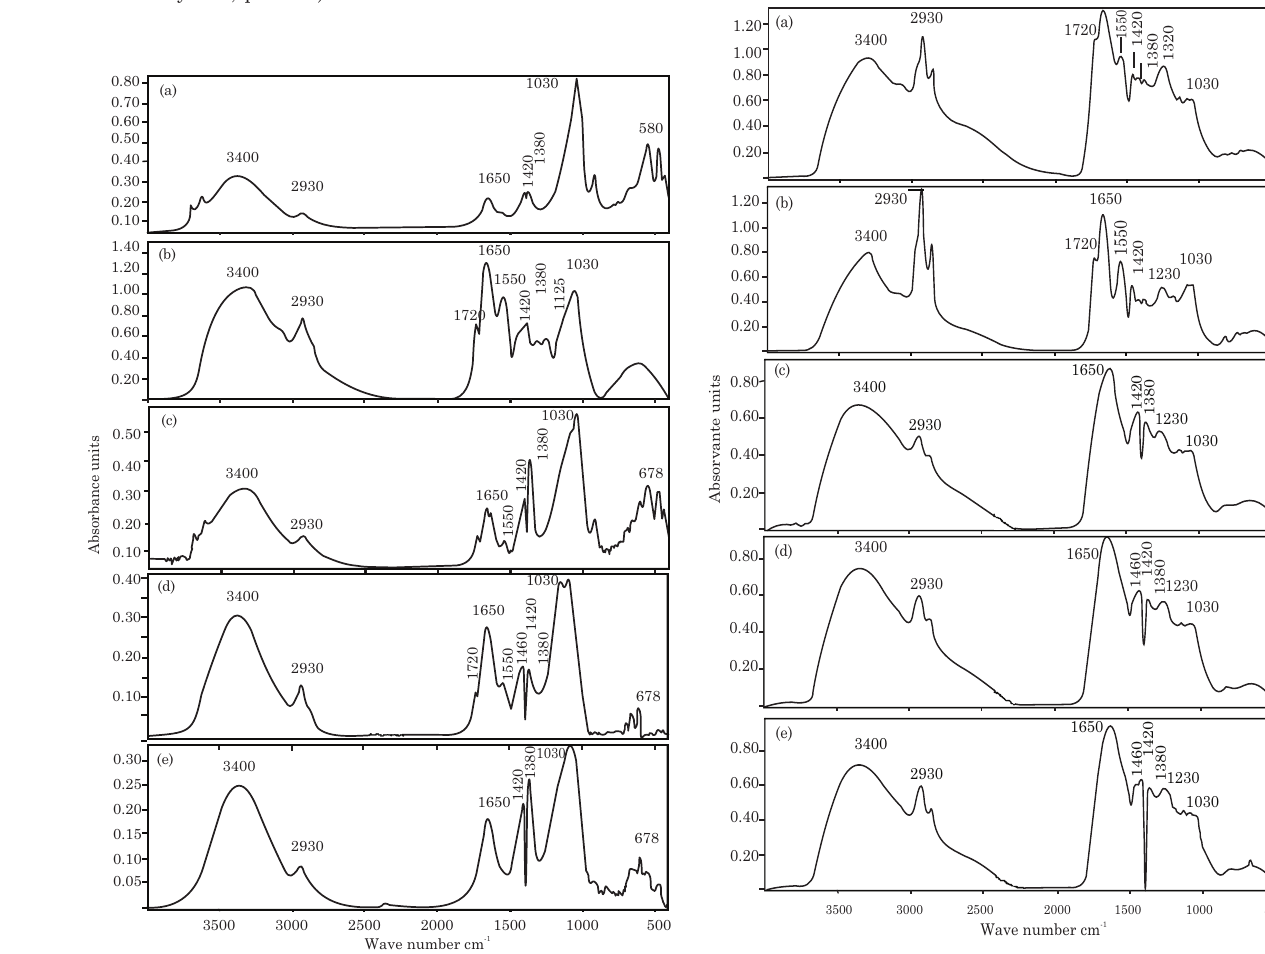
Figure 1. Infrared spectra of dissolved organic matter: (a) unamended soil (prior to the experiment), (b) sewage sludge (SS), (c) inorganic fertilizer-soil (S-230), (d) sewage sludge-treated soil, low rate (SL-230), (e) sewage sludge-treated soil, high rate (SH-230).